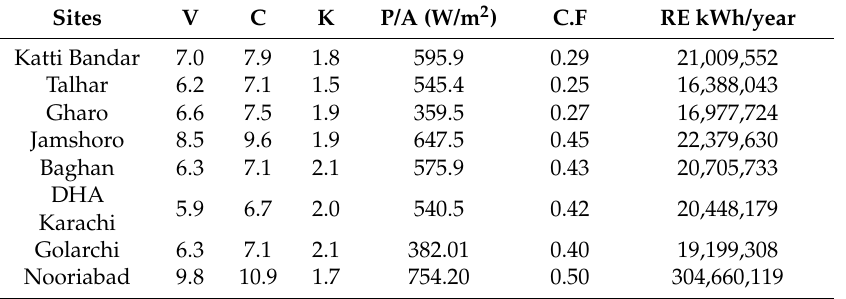
Table 5. Annual mean Weibull parameters, wind power density and energy for eight locations.